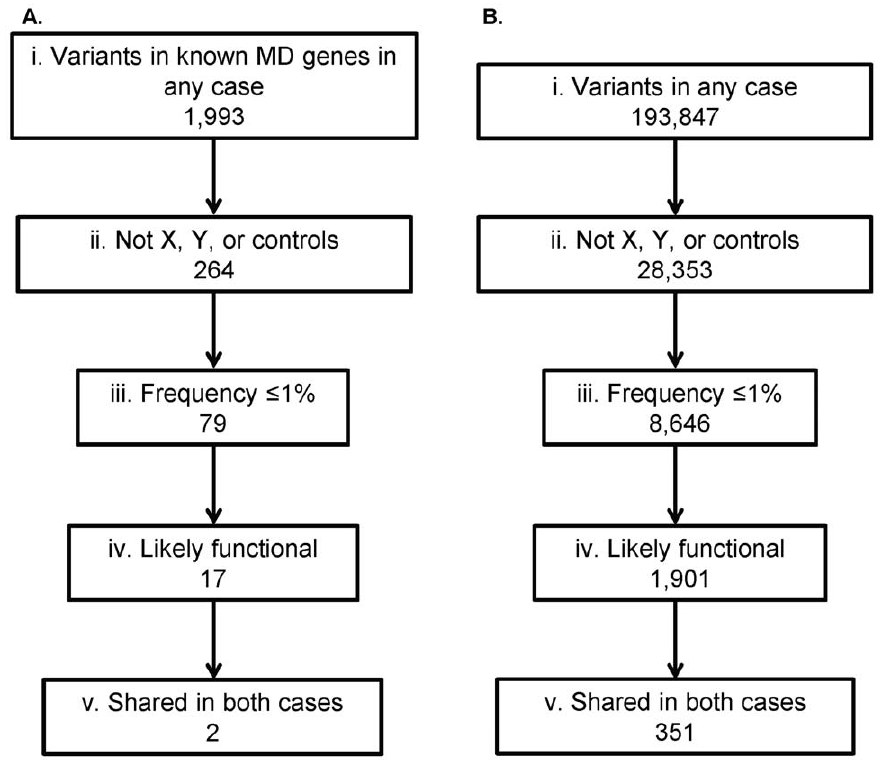
Figure 4. Filtering of variants identified through exome sequencing of individuals in LGMD2692. Variant filtration was performed for all variants (SNVs and indels) identified in known muscle disease genes (A) and in all genes (B). The total number of variants identified in either of the cases (i) was restricted to variants that were not on the X or Y chromosomes and were not identified in any of the control individuals (ii). This list was further reduced to variants at # 1% frequency in the HapMap and 1000 Genomes Caucasian databases (iii), then to likely functional variants or variants within 10 bases of a splice site (iv), and finally to variants that are shared in both cases (v).